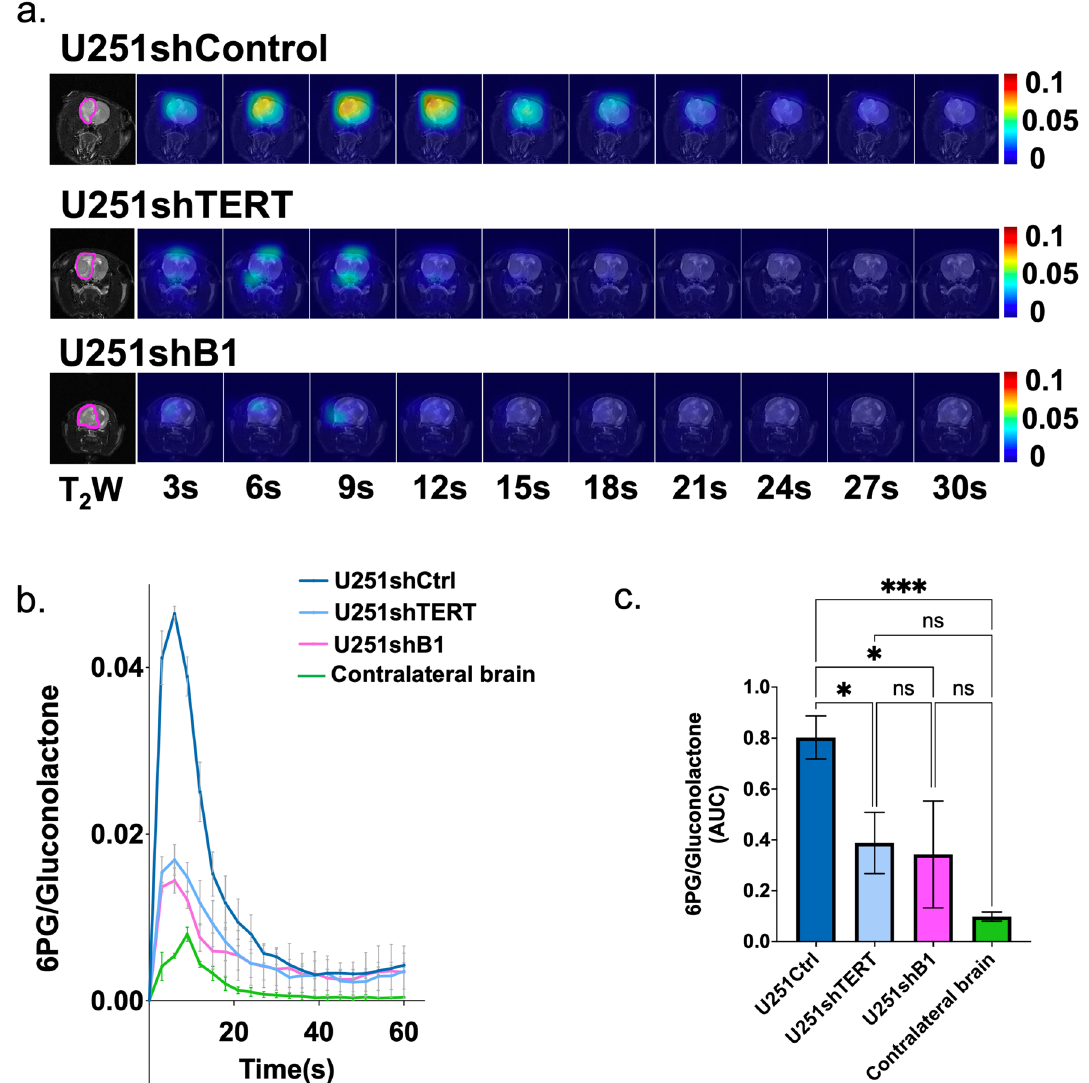
Figure 5. ( a ) Dynamic hyperpolarized 13 C echo-planar spectroscopic imaging of [1- 13 C]6PG acquired with 3 s temporal resolution. ( b ) Temporal evolution of [1- 13 C]6PG comparing U251shCtrl, U251shTERT, U251shB1 tumors, and contralateral normal brain. ( c ) The AUC of [1- 13 C]6PG comparing U251shCtrl, U251shTERT, U251shB1 tumors, and contralateral normal